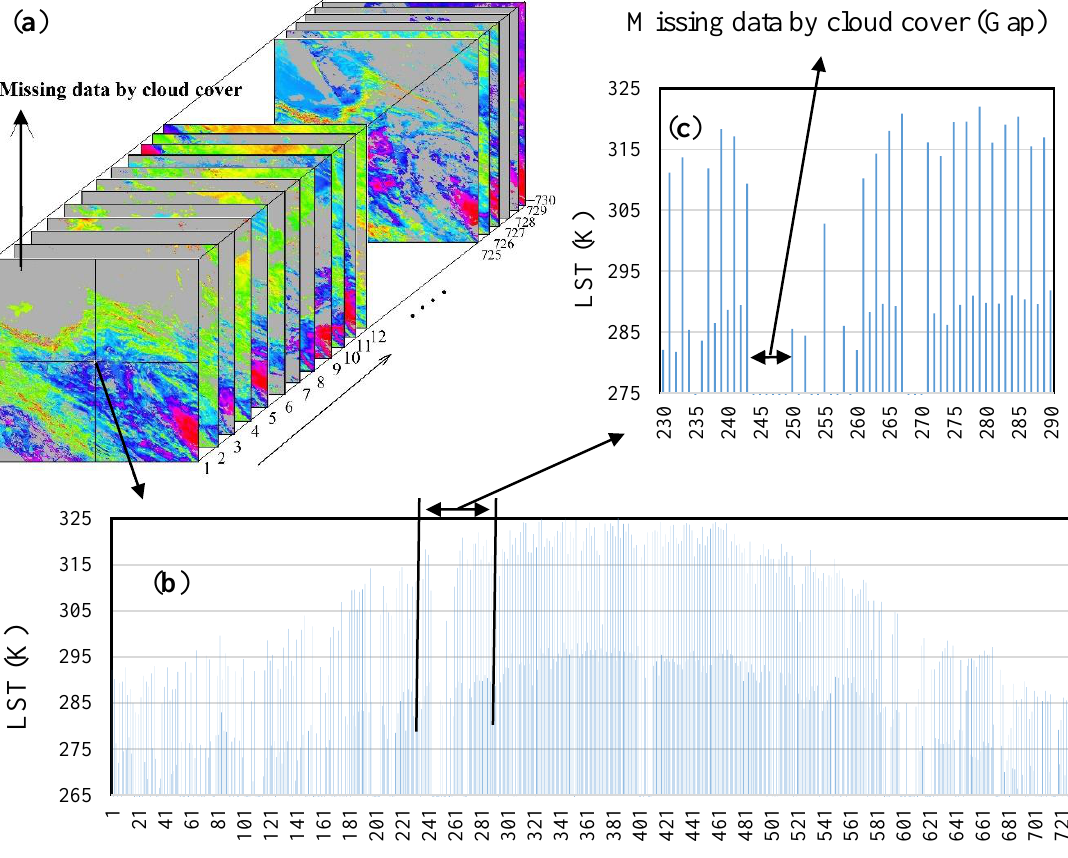
Figure 2. Time series with 730 images ( a ), trend of temperature changes along one pixel ( b ), and magnification of a part of time series ( c ).